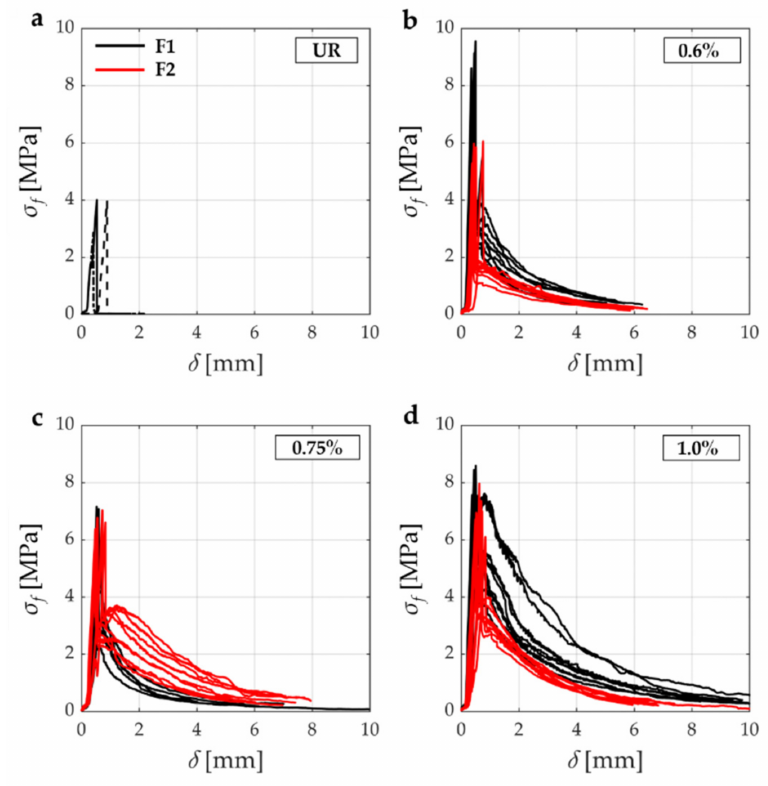
Figure 13. Bending stress σ f vs. vertical displacement in the 3PBTs for: ( a ) Un-strengthened case (UR). Strengthened cases with two fiber types (F1 and F2) and three fiber contents, F : ( b ) 0.6%; ( c ) 0.75%; ( d )